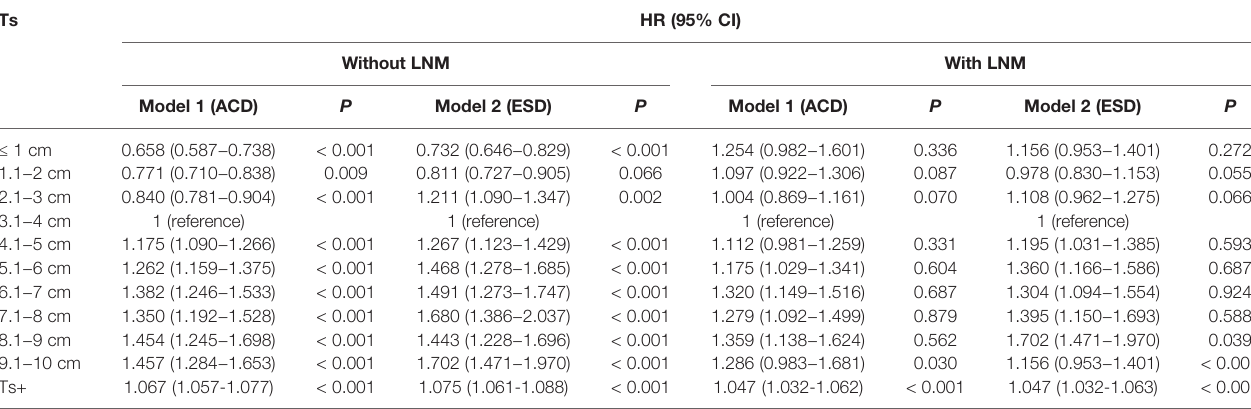
Model 1: Results of multivariate Cox proportional hazards models for ACD after adjustment for age, histological type, race, grade, stage, lymph node status, number of lymph node examined, andtumornumber. Mode2: Resultsofmultivariate Coxproportional hazards modelsforESDafteradjustment forage,histological type,race, grade,stage, lymph node status, number of lymph node examined, and tumor number. Ts+: Ts was analyzed as a continuous variable. Ts, tumorsize; HR, hazard ratio; CI, con fi dence interval; ACD, all-cause death; ESD, endometrial cancer-speci fi c death; LNM, lymph node